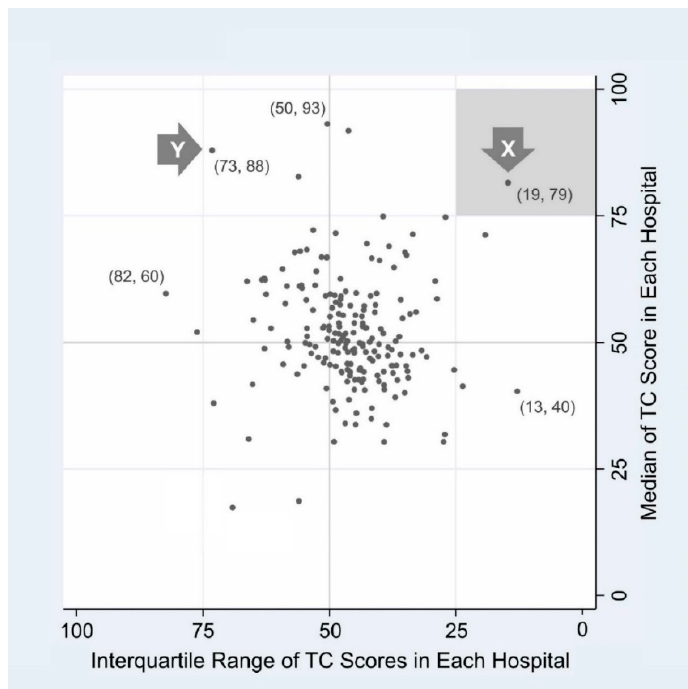
Figure 2. The Jeong & Lee plot of 200 hospitals participating in the Taiwan patient safety culture survey. Figure 2. The safety culture grid (Jeong & Lee plot) of 200 hospitals participating in the Taiwan patient Note that the method we proposed can be applied to any safety culture survey instrument.. Because of safety culture survey. Note that the method we proposed can be applied to any safety culture survey space limits, we rounded o ff to the nearest whole number. Usually work area is used as an analytic instrument, as long as it utilizes a Likert scale. Because of space limits, we rounded off to the nearest cluster, but in this national sample, we used hospital as the analytic cluster. Users can always choose whole number. and switch group levels as unit of